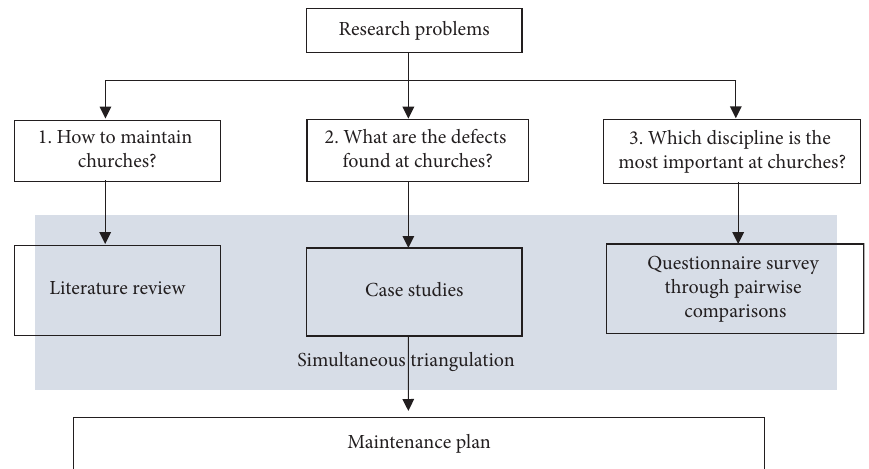
Figure 1: Methodology used to propose maintenance plan for Anglican churches in